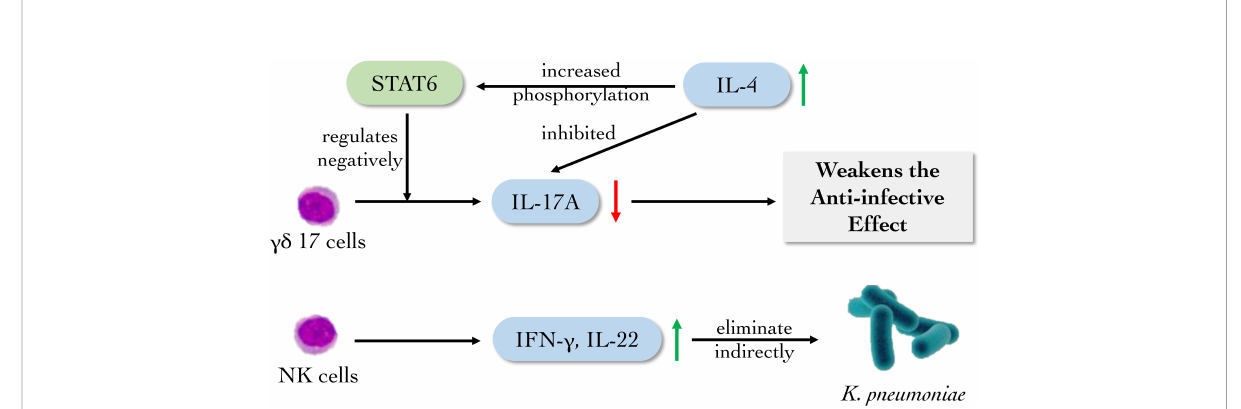
FIGURE 5 The main role of innate lymphoid cells against K. pneumoniae . NK cells and its subsets mainly eliminate K. pneumoniae indirectly by producing cytokines. gd 17 cells facilitate the eradication of K. pneumoniae by secreting IL17A, which can be suppressed by high level of